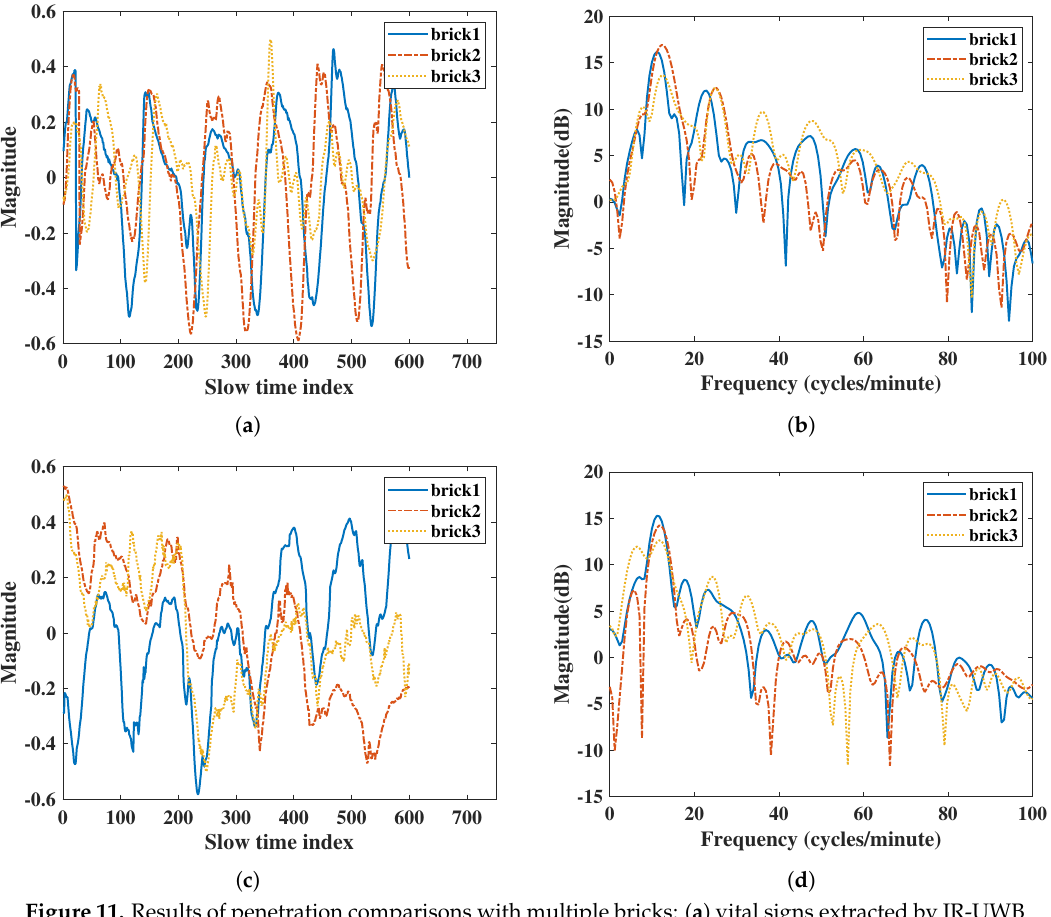
Figure 11. Results of penetration comparisons with multiple bricks: ( a ) vital signs extracted by IR-UWB radar in the time domain, ( b ) vital signs extracted by IR-UWB radar in the frequency domain, ( c ) vital signs extracted by FMCW radar in the time domain, ( d ) vital signs extracted by FMCW radar in the frequency